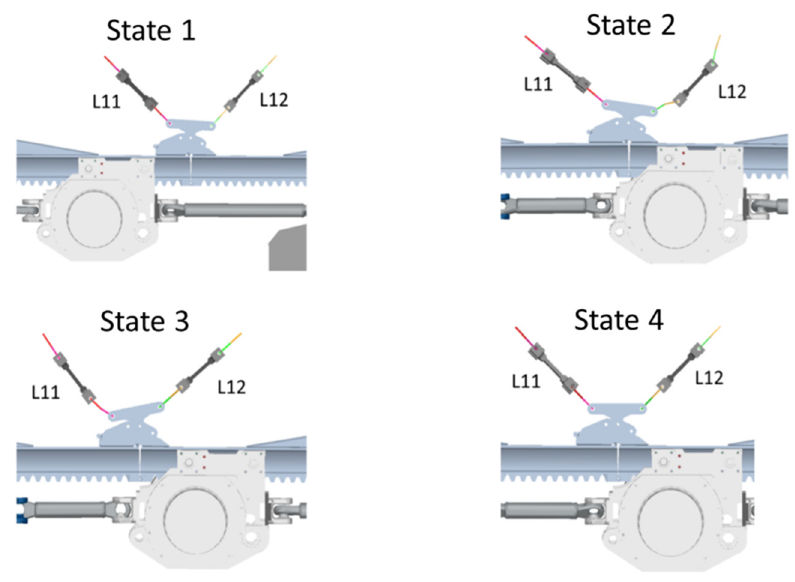
Figure 15. Successive loads to the suspensions resulting from the change of the position of the traverse in the rails suspensions.